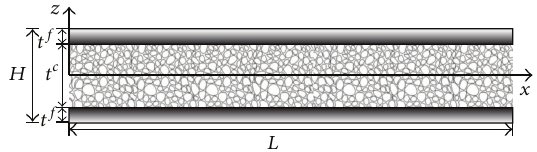
Figure 1: Functionally graded sandwich